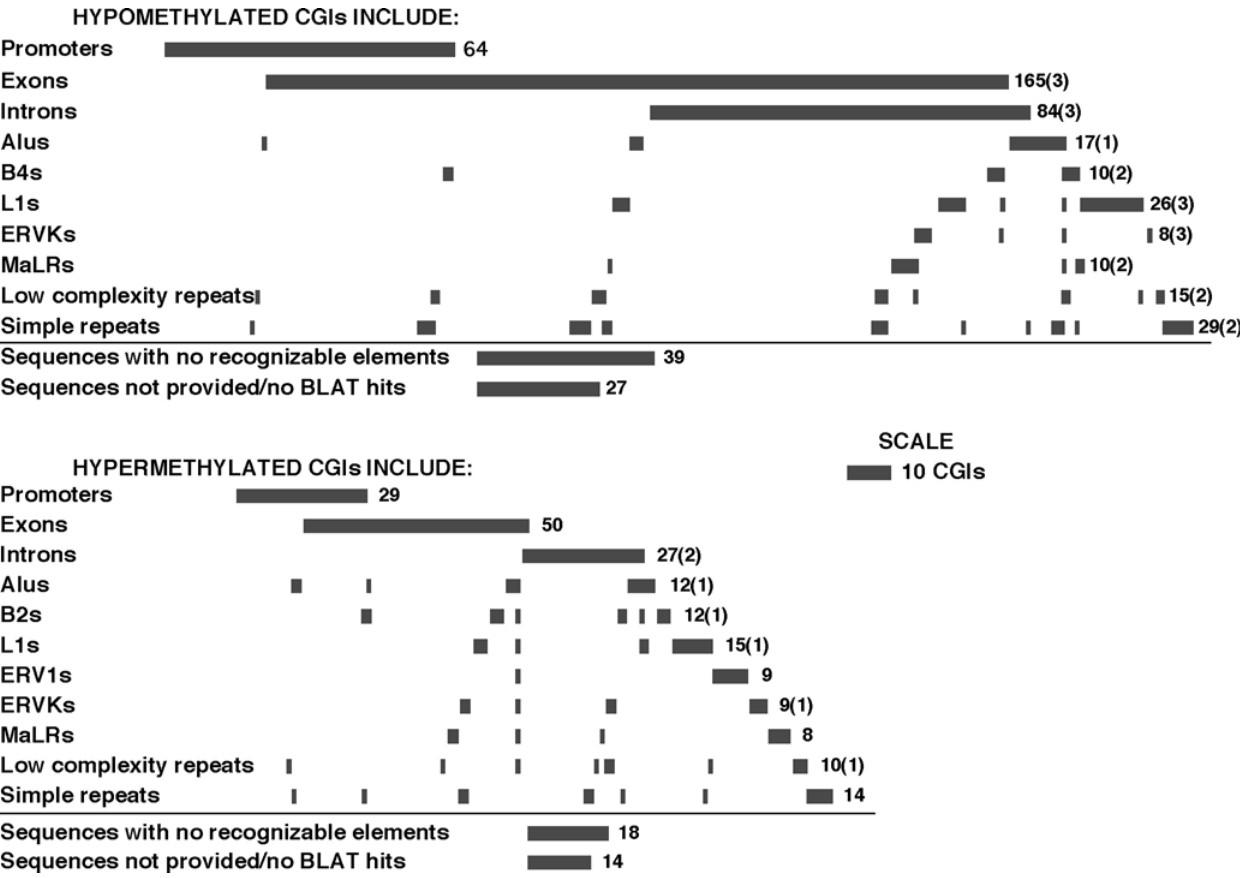
Figure 5. Genomic characteristics of abnormally methylated CGIs in the hippocampal pyramidal layer of P3 cocaine-treatment pups. Information associating abnormally methylated CGIs with various genomic elements was obtained by BLAT analysis of the affected CGIs as determined from the MeDIP/CGI array profiling experiments. The data is limited to the genomic elements that are present in at least 5 CGIs. The number of CGIs associated with a particular genomic element is represented by horizontal bars across from the element’s name. The length of the bar is proportional to the number of CGIs; this number is also given at the end of the row. The number of CGIs with sequences matching more than one position in the genome is provided in parenthesis. The tendency for CGIs to be associated with more than one genomic element is reflected in the partial overlap of the bars on most rows. Note that overall there are more hypomethylated CGIs than hypermethylated CGIs.